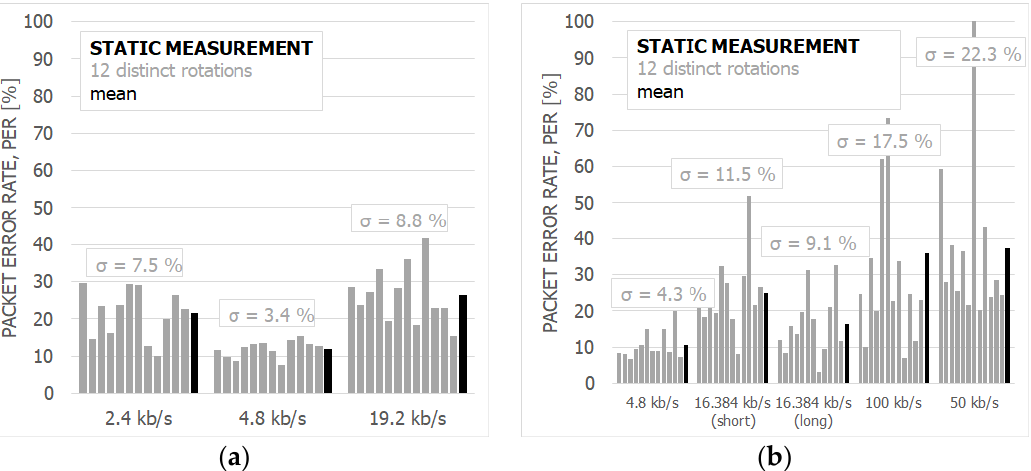
Figure 12. Packet Error Rate measurements for Wireless M-Bus obtained in the LKE (WUST) rever- beration chamber: ( a ) static measurements at 169 MHz, ( b ) static measurements at 868 MHz.